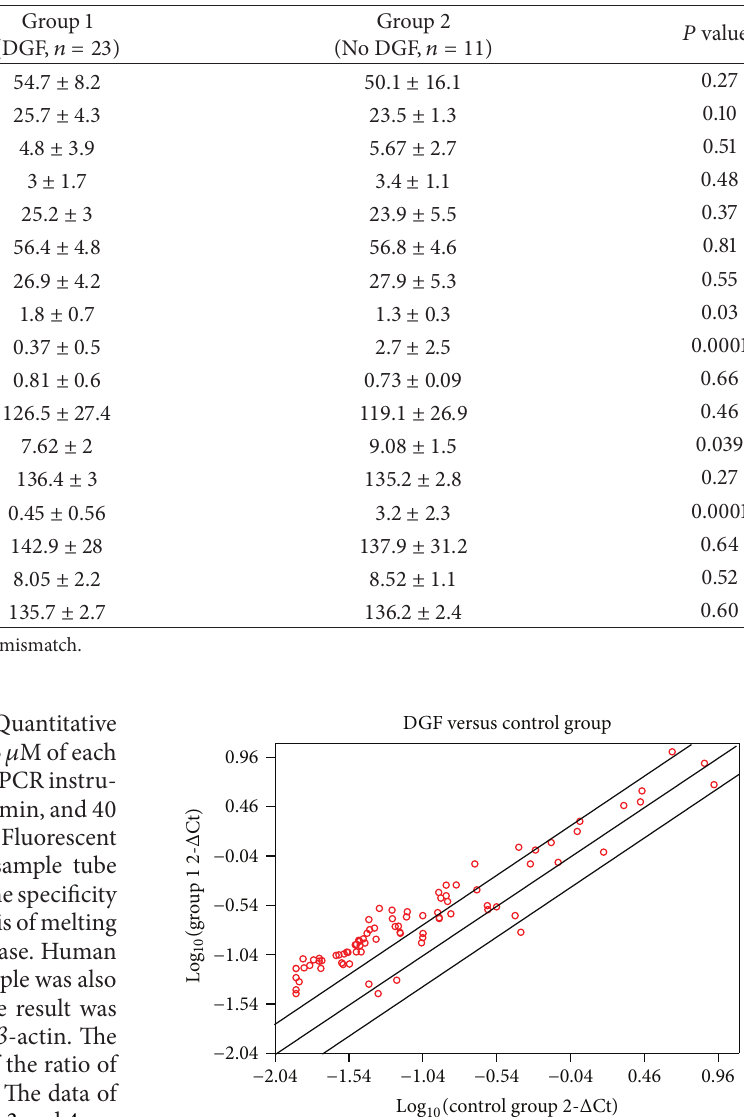
Table 2: Characteristics of renal transplant patients.